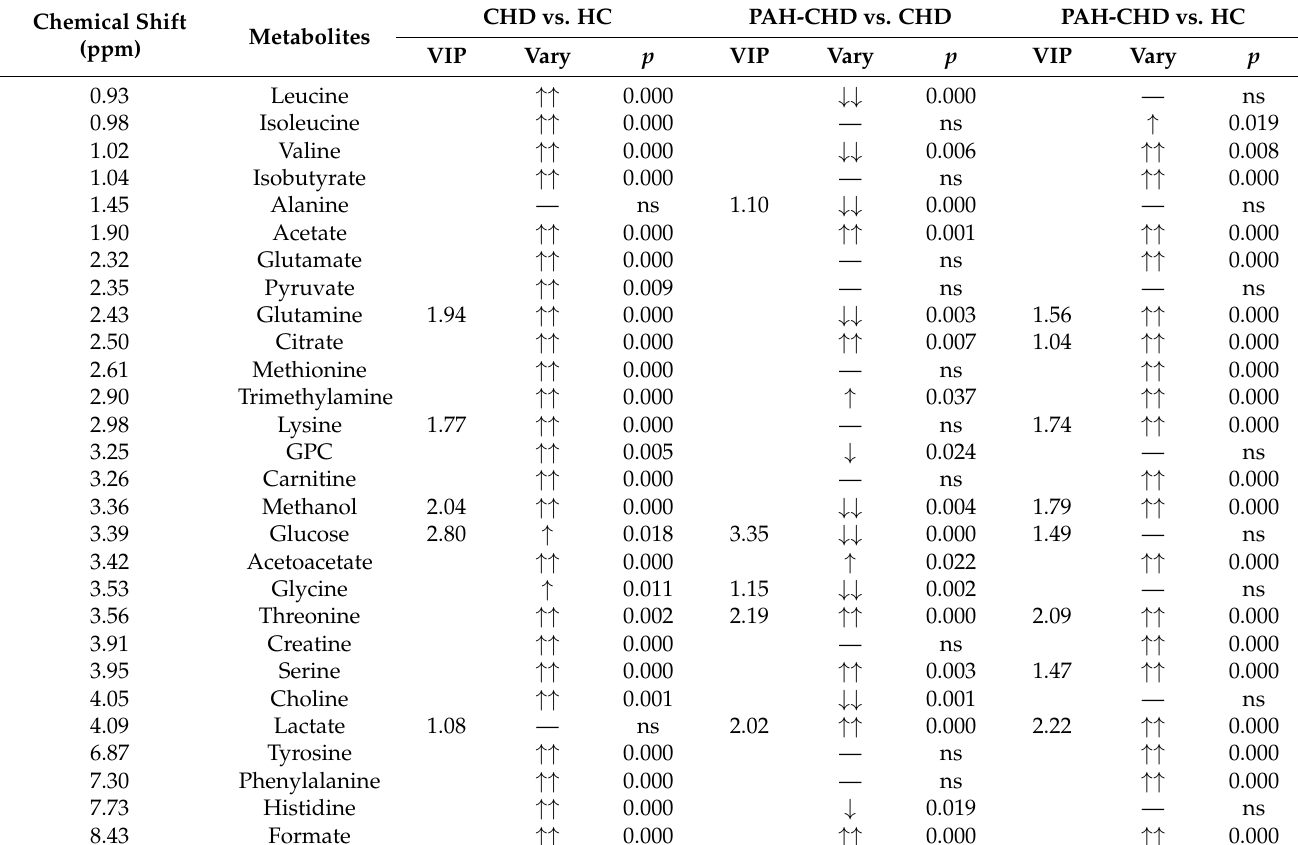
Table 2. The chemical shift and variation of each metabolite level among the three